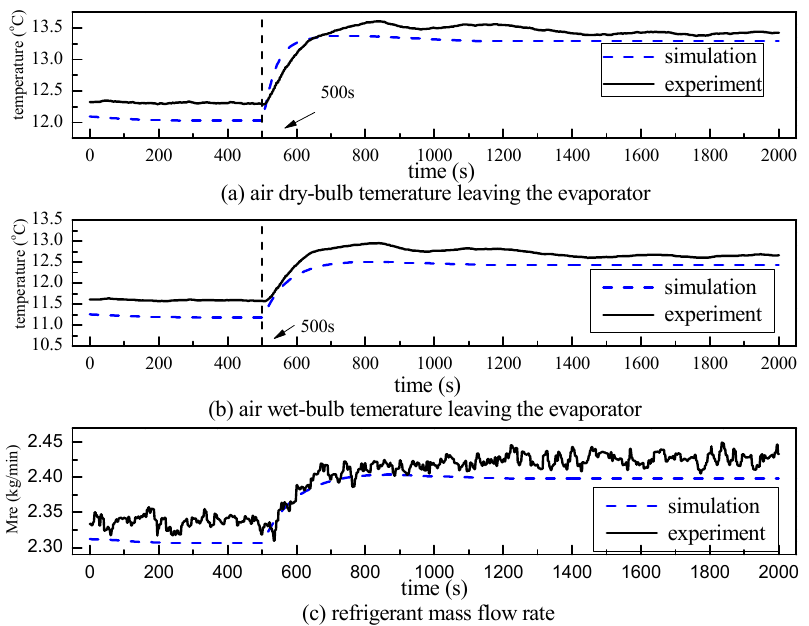
Figure 4. Comparison results for the predicted and measured open loop responses, ( a ) the predicted and measured air dry-bulb temperature; ( b ) the predicted and measured air wet-bulb temperature; ( c ) the predicted and measured refrigerant mass flow rate.